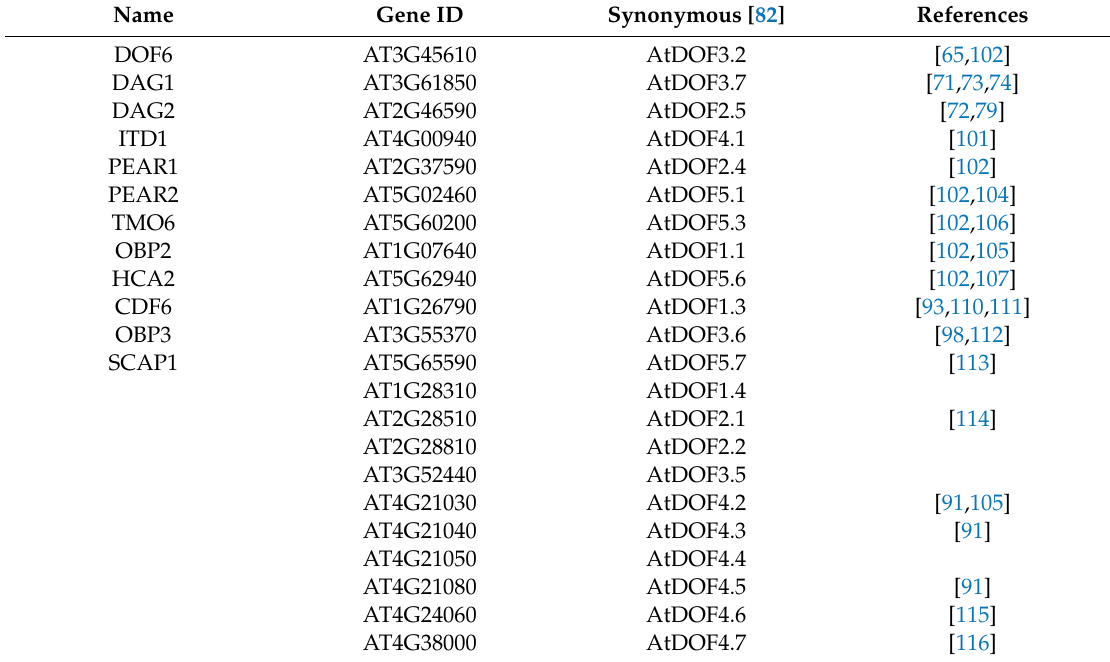
Table 3. Arabidopsis DOF genes marked by